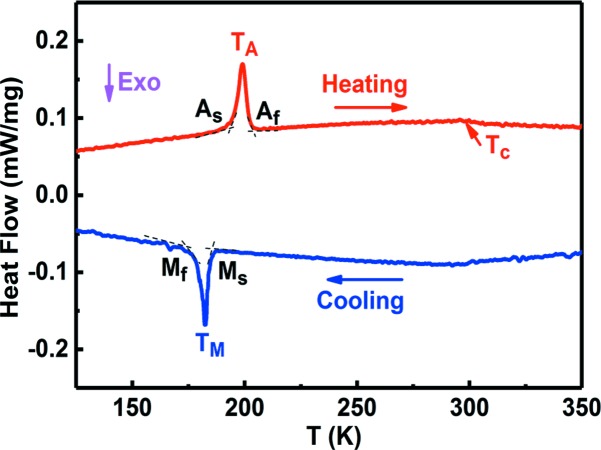
Heating and cooling DSC curves for the Ni43.7Cu1.5Co5.1Mn36.7In13 microwire. The phase transformation temperatures are determined as illustrated in the figure. The Curie temperature of austenite T
c is denoted by an arrow.